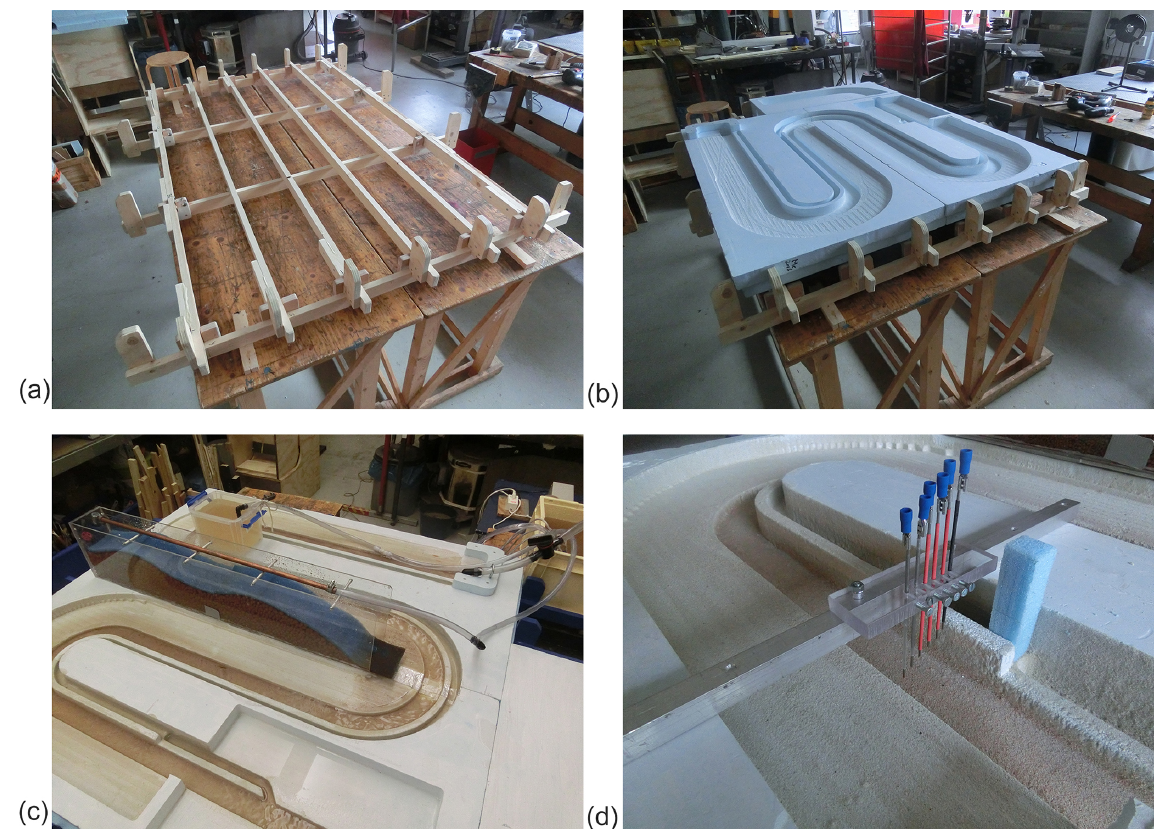
Figure B2. (a, b) The making of the wooden support frame with its bolt–nut system. (c) Overview with moor and the first reservoir; notice the aluminium tape sealing two foam plates. (d) Detail of canal and sluice gate as well as a water-level measurement device involving Arduino